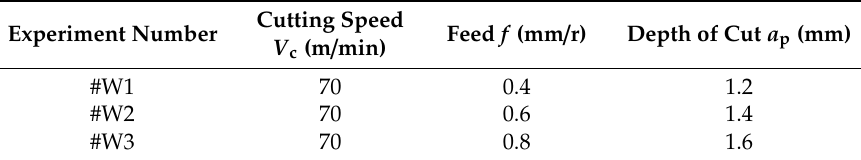
Table 3. Turning parameters of the wheel specimens.